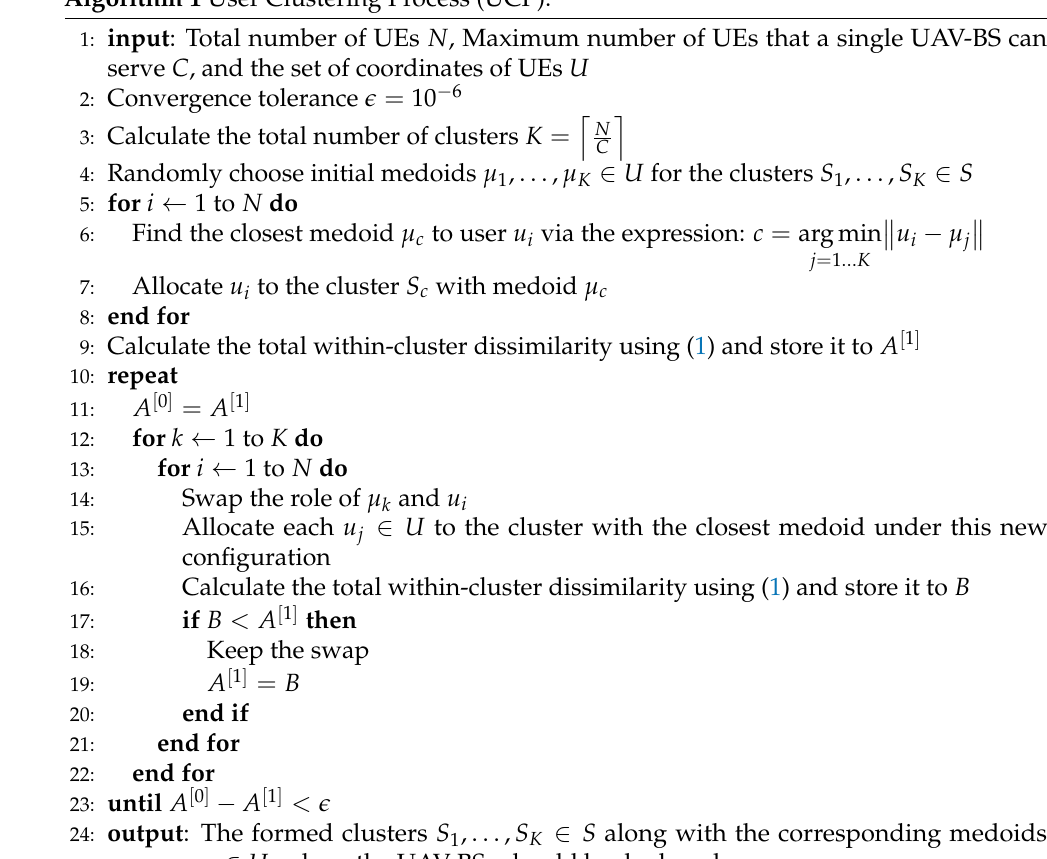
Algorithm 1 User Clustering Process